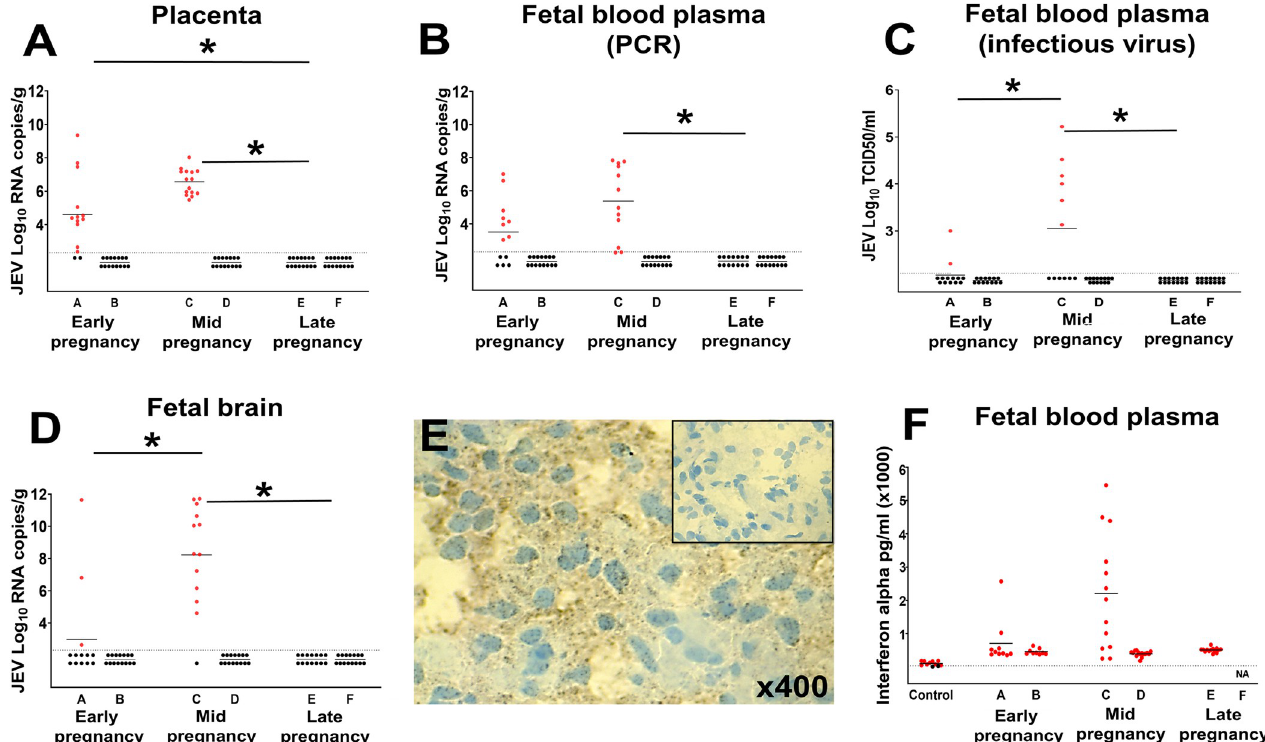
Fig 5. Japanese encephalitis virus infection in fetuses. ( A ) JEV RNA loads in the placenta. JEV RNA loads ( B ) and infectious titers ( C ) in fetal blood. ( D ) JEV RNA loads in fetal brains. ( E ) JEV-specific immunohistochemistry in the brain from a virus-negative fetus (insert) and in the brain from the fetus positive for JEV; brown staining represents cells positive for the JEV envelope protein. ( F ) IFN- α concentrations in fetal blood plasma. Control blood plasma samples were from fetuses of two healthy pigs sampled at 78 days of pregnancy in our previous studies [35]. Dots represent individual pigs or fetuses. The dotted line is the detection limit—36 pg/ml. In fetuses, the short horizontal line represents mean values. In all graphs, dots represent individual fetuses. The dotted line is the detection limit. The short horizontal line represents mean values. � : JEV loads were significantly different.